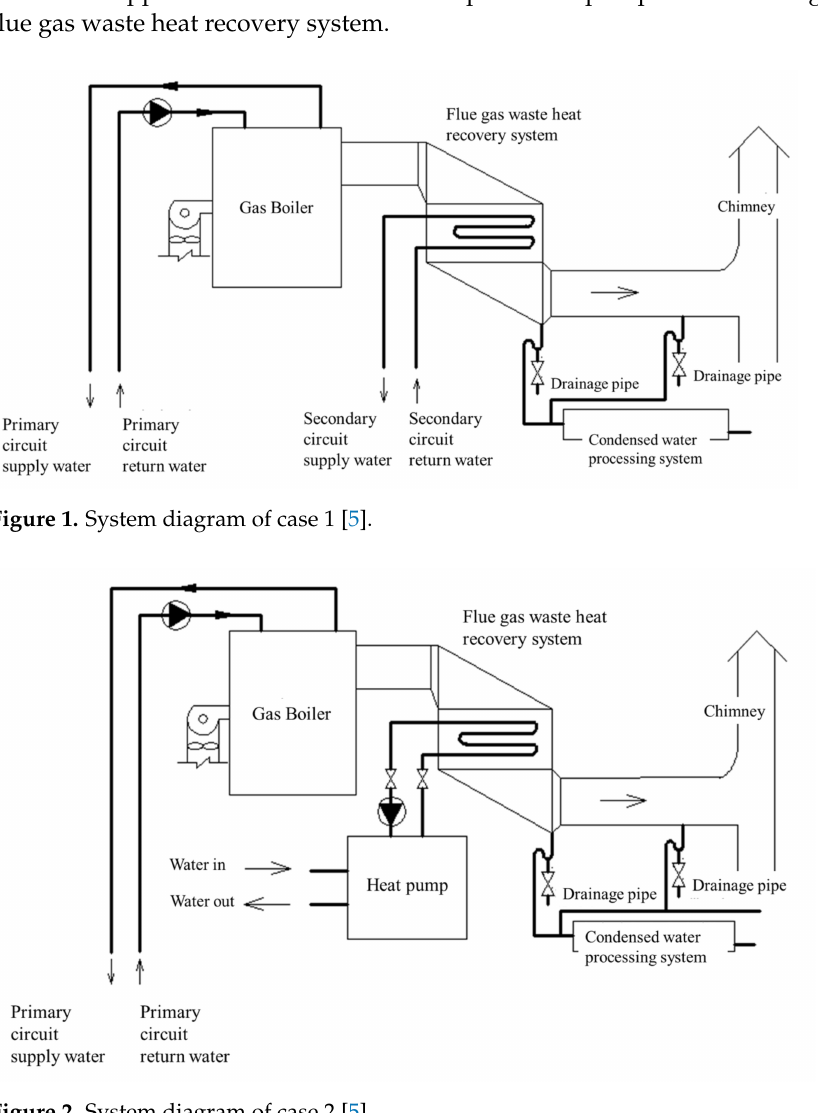
Figure 2. System diagram of case 2